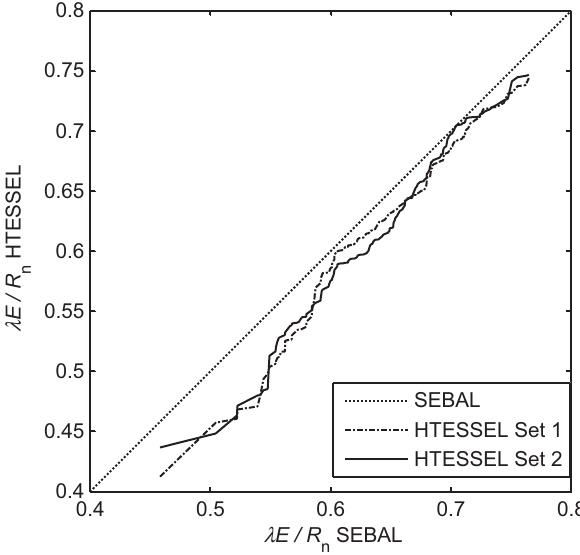
Fig. 11. HTESSEL seasonally averaged evaporative fraction λE / R n values for each grid cell being ranked from low to high values and plotted against ranked SEBAL λE / R n . The SEBAL evaporation is averaged over 30 weeks starting in week